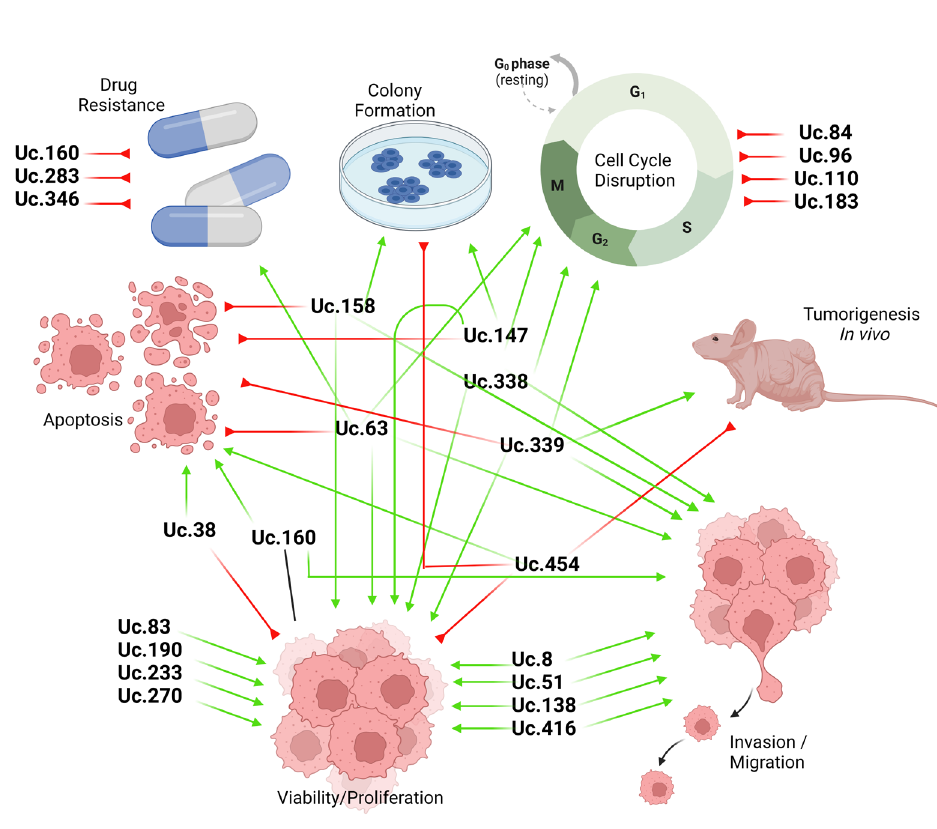
Figure 4 - Transcribed ultraconserved regions (T-UCRs) associated with cancer cell processes. They mostly affect cell proliferation, migration/invasion and apoptosis in distinct tumor types. Green arrows meaning promotion and red arrows meaning suppression of the mechanisms. Created with